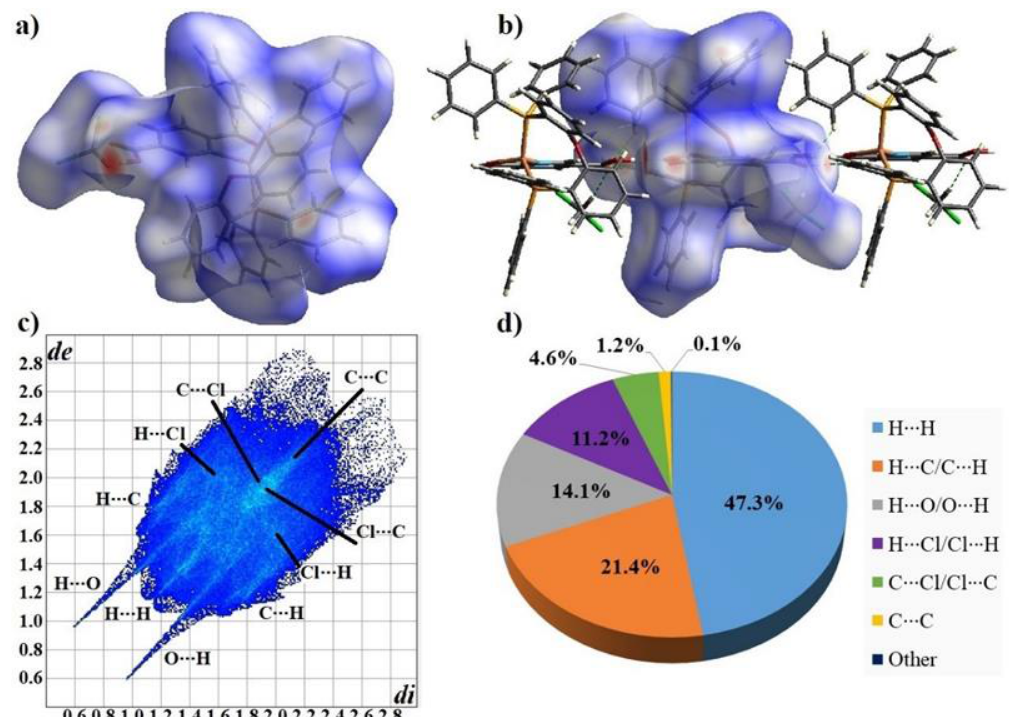
Figure 2. ( a , b ) Hirshfeld surface maps ( d norm ) of compound 1 viewed from different perspectives. ( c ) Fingerprint plot. ( d ) Contributions of different types of intermolecular interactions.